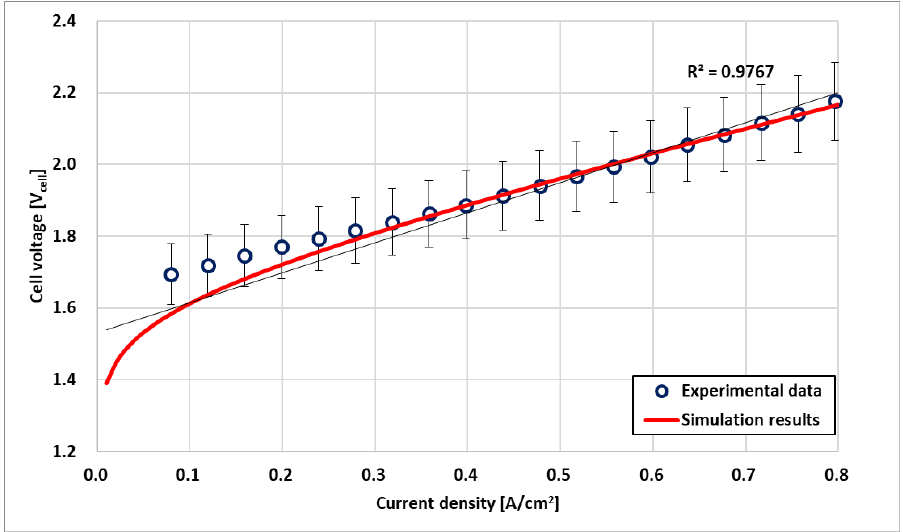
Figure 3. Electrochemical model validation based on experimental data.